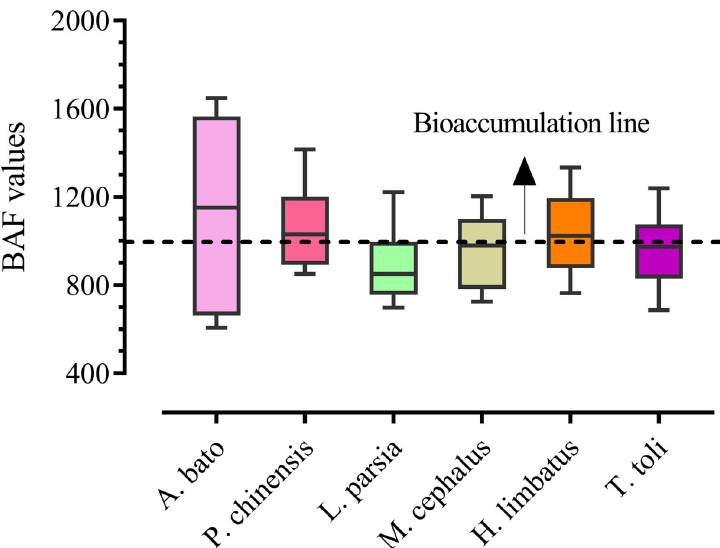
Fig 4. Bioaccumulation factor among the species that varied from particular metals and species.